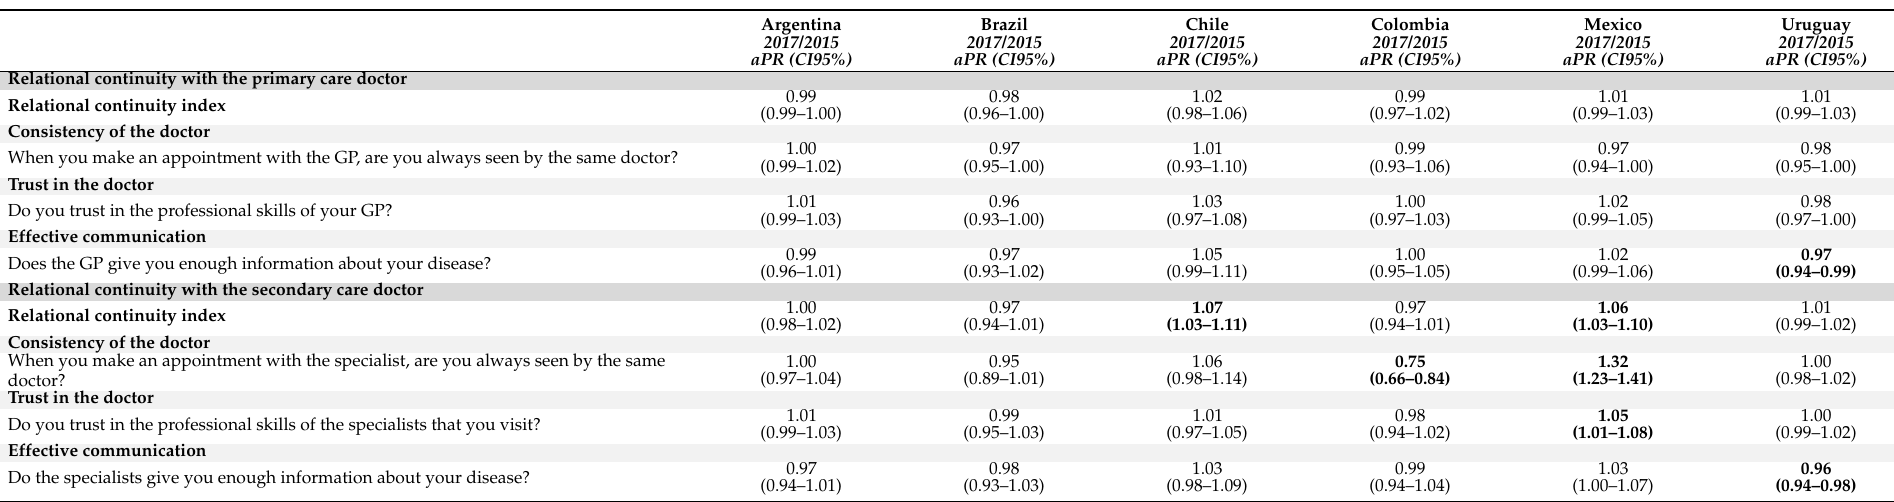
Table 3. Changes in the perception of relational continuity with the primary care doctor and the secondary care doctor in the health services networks between 2015 and 2017, by